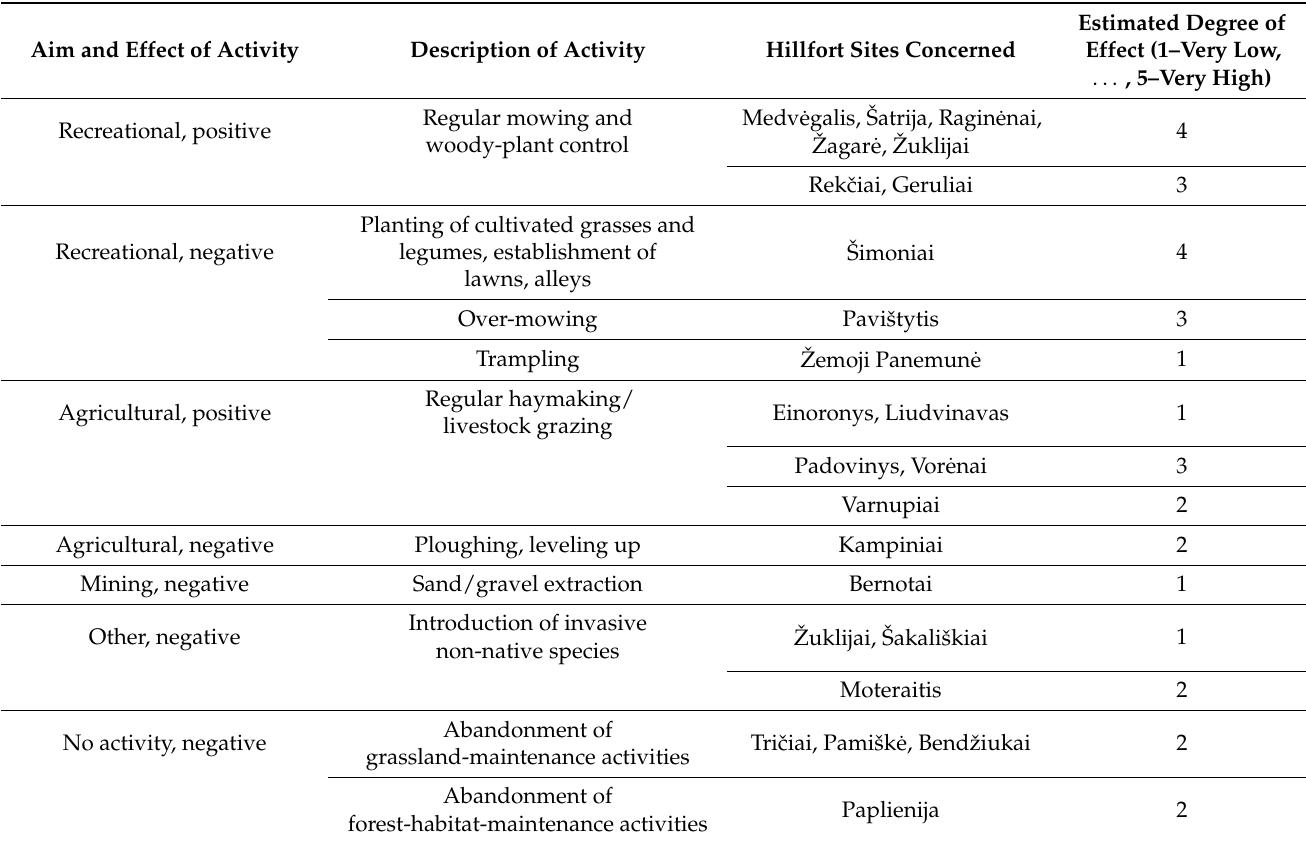
Table 4. Evaluation of anthropogenic activities affecting target-species populations at hillfort sites